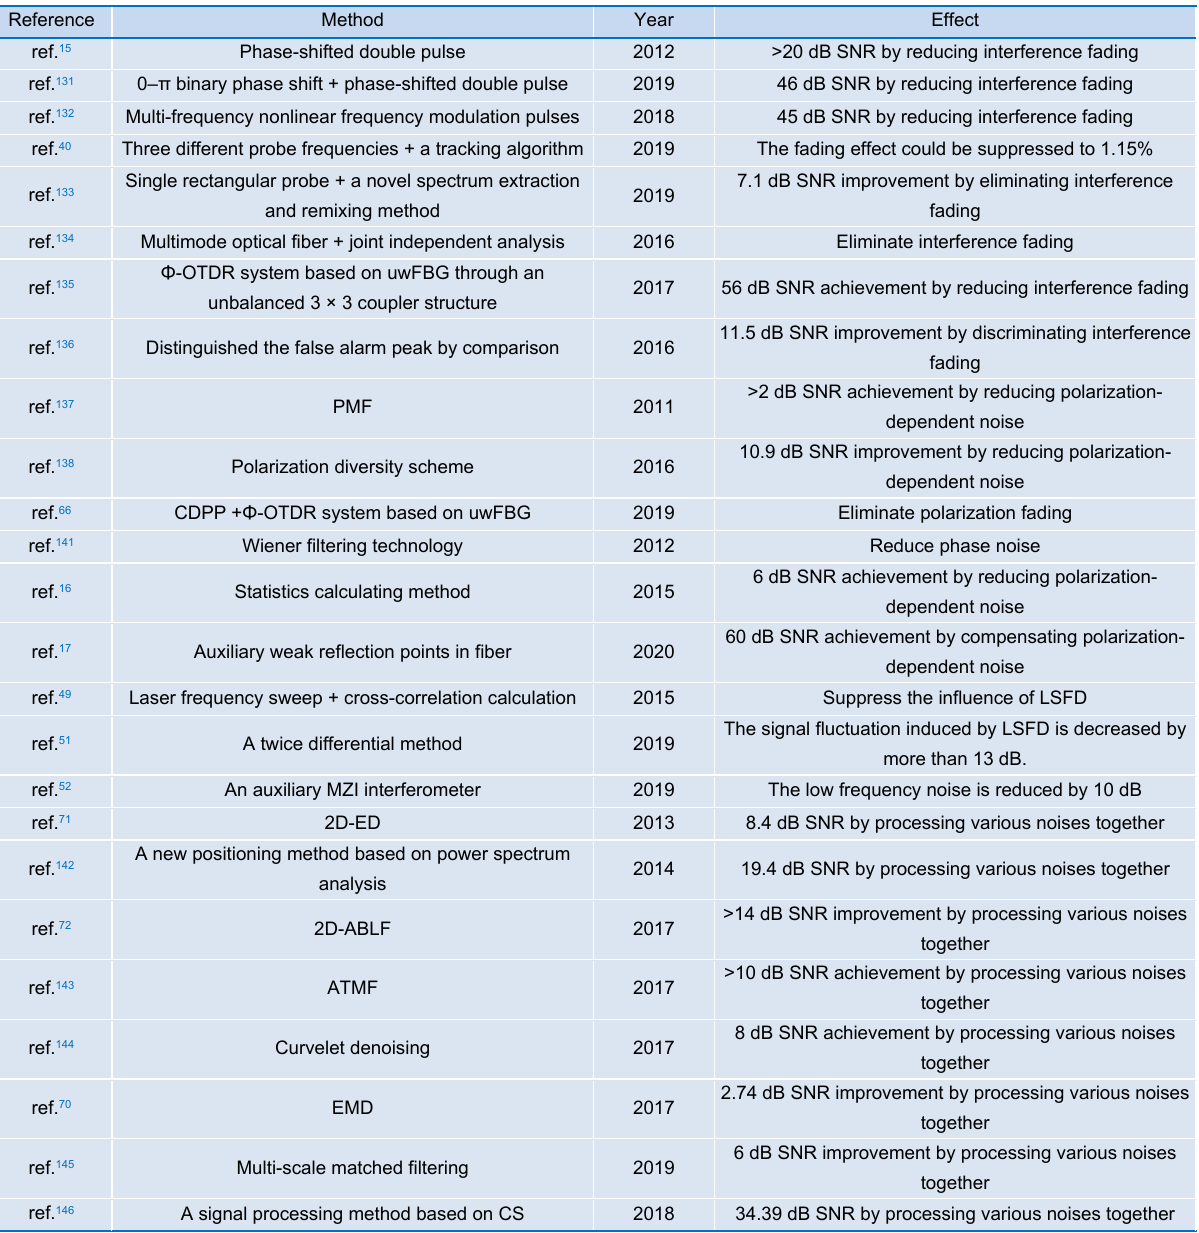
Table 2 | Research progress on improving the SNR in Ф-OTDR